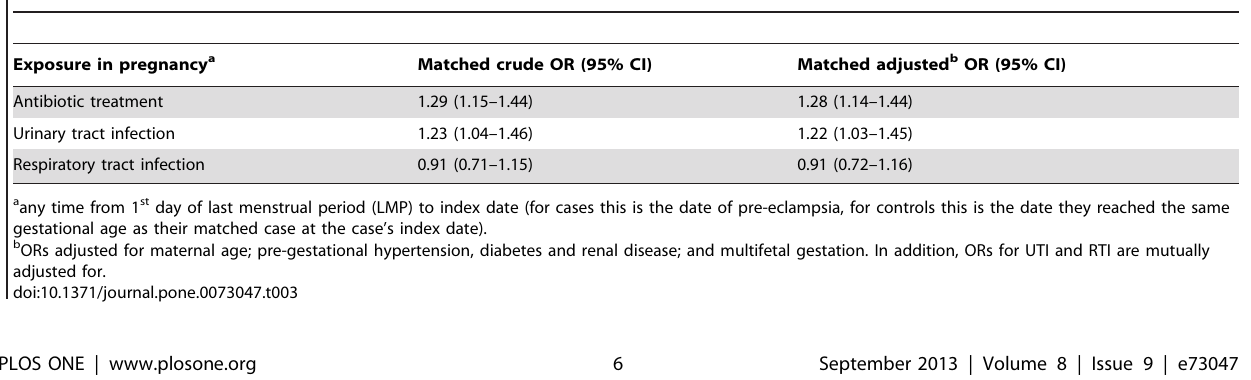
Table 3. The association between maternal infection and pre-eclampsia: crude and adjusted odds ratios for matched cases (n=1533) and controls